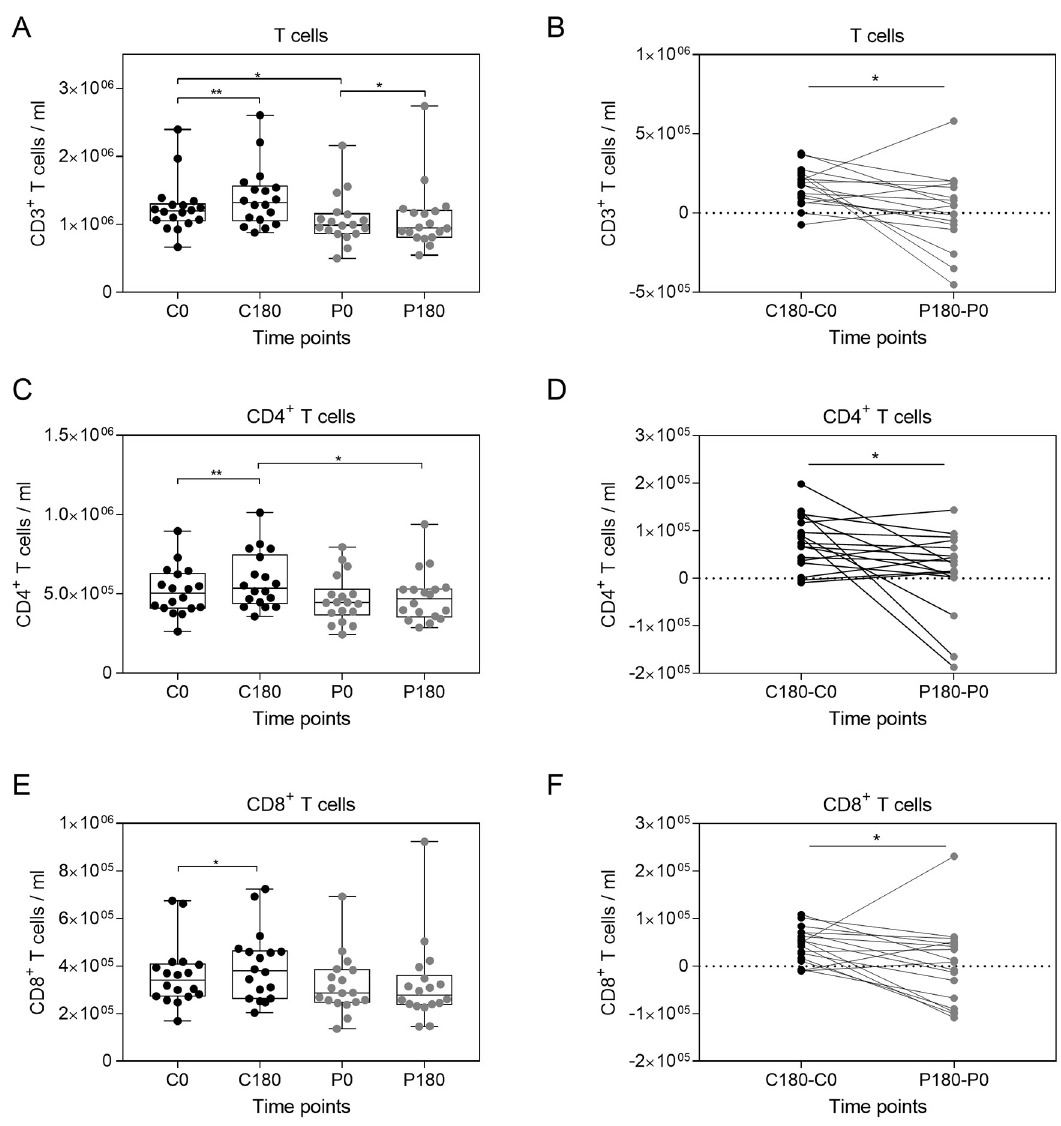
Fig 4. T cells numbers are altered during parabolic flight maneuvers. Total T cells were quantified by flow cytometry according to CD3 expression (A). The CD3 positive T cells were further discriminated into CD4 (C) and CD8 (E) expressing T cells, respectively. The differences between the control period and the parabolic flight period were compared for the whole CD3 + T cell pool (B), CD4 + T cells (D), and CD8 + T cells (F). Asterisks indicate p-values ( �� p < 0.01; � p < 0.05). See S5 Fig for details on the gating strategy.